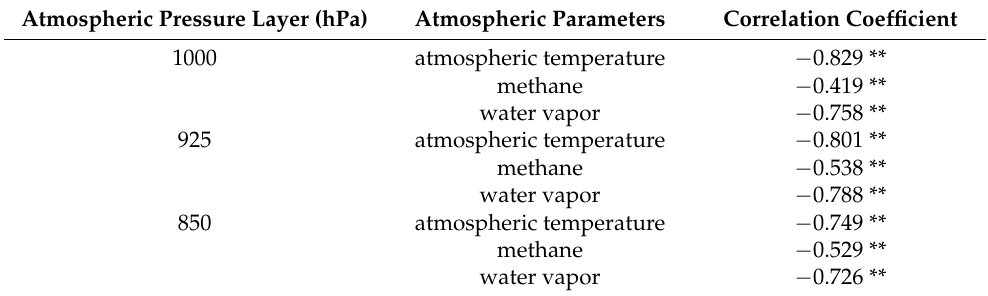
Table 6. Correlations between atmospheric temperature, methane, water vapor, and CO in the global lower troposphere from 2003 to